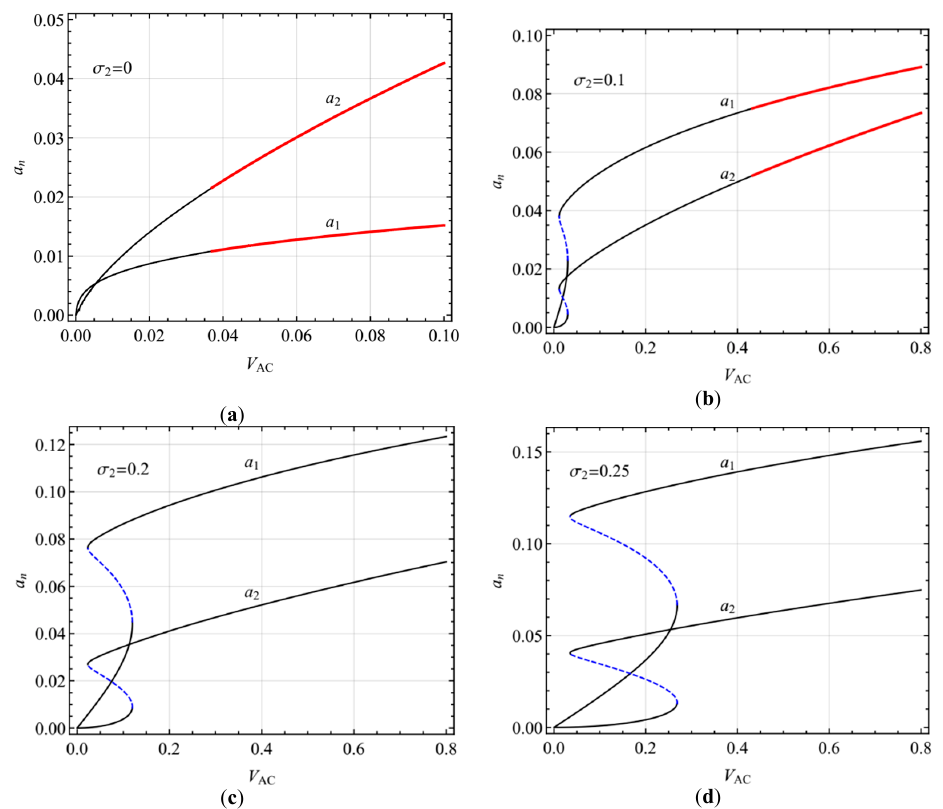
Figure 6. Response amplitude varying with exciting amplitude in the primary resonance of the first mode for different exciting frequencies: ( a ) σ 2 = 0; ( b ) σ 2 = 0.05; ( c ) σ 2 = 0.10; ( d ) σ 2 = 0.15.